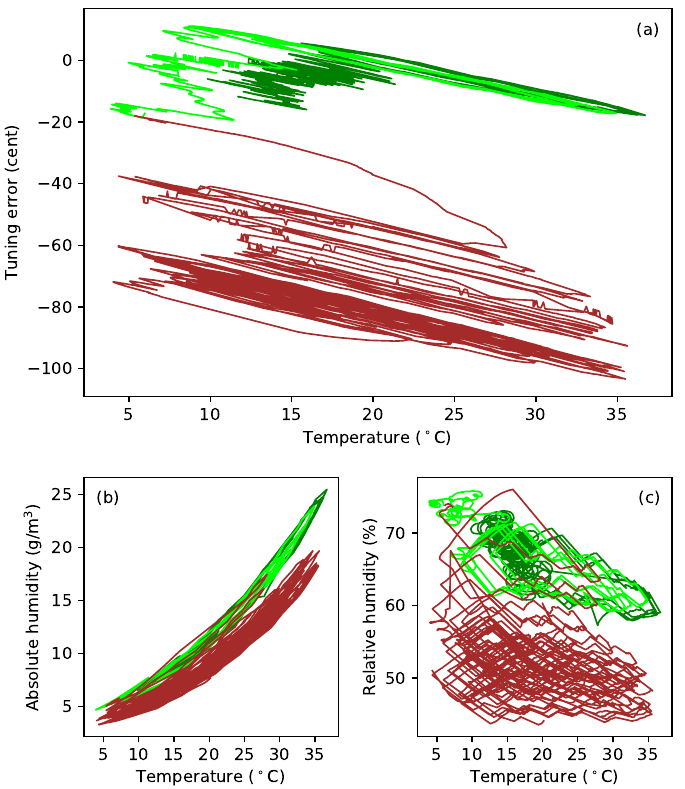
Figure 8. ( a ) The tuning error, ( b ) the absolute humidity, and ( c ) the relative humidity, all plotted against temperature, for the extended tests run with strings G5b (green) and G5c (lime) following completion of the initial series of tests at the last target fundamental frequency of 324 Hz. The brown sections show the responses for string G5c when the water reservoir was subsequently removed and heating